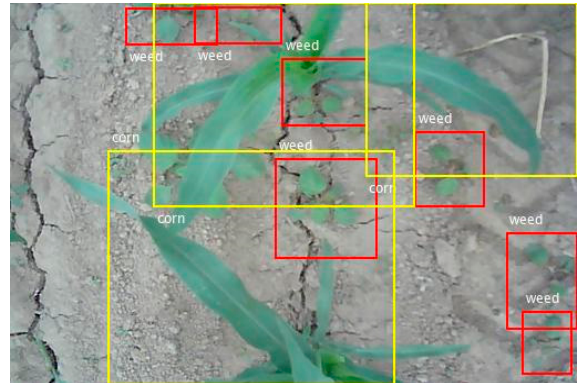
Figure 10. Experimental effect Ⅱ .